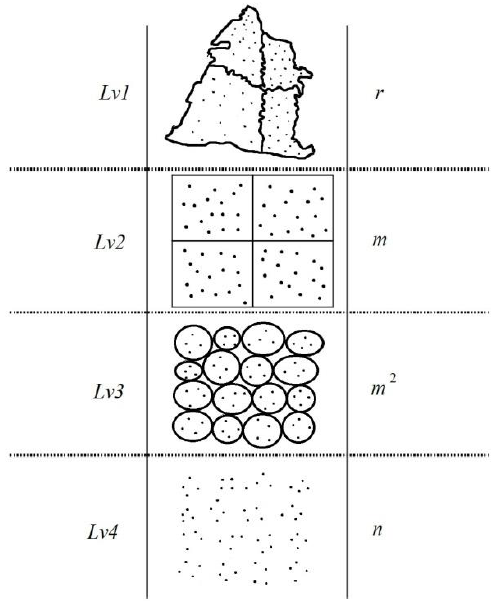
Figure 2. Smallest units of the administrative district are grouped with a sociological idea.